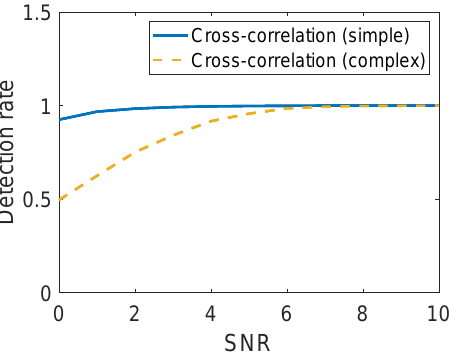
Figure 18. Detection rate comparison of different decision rules for